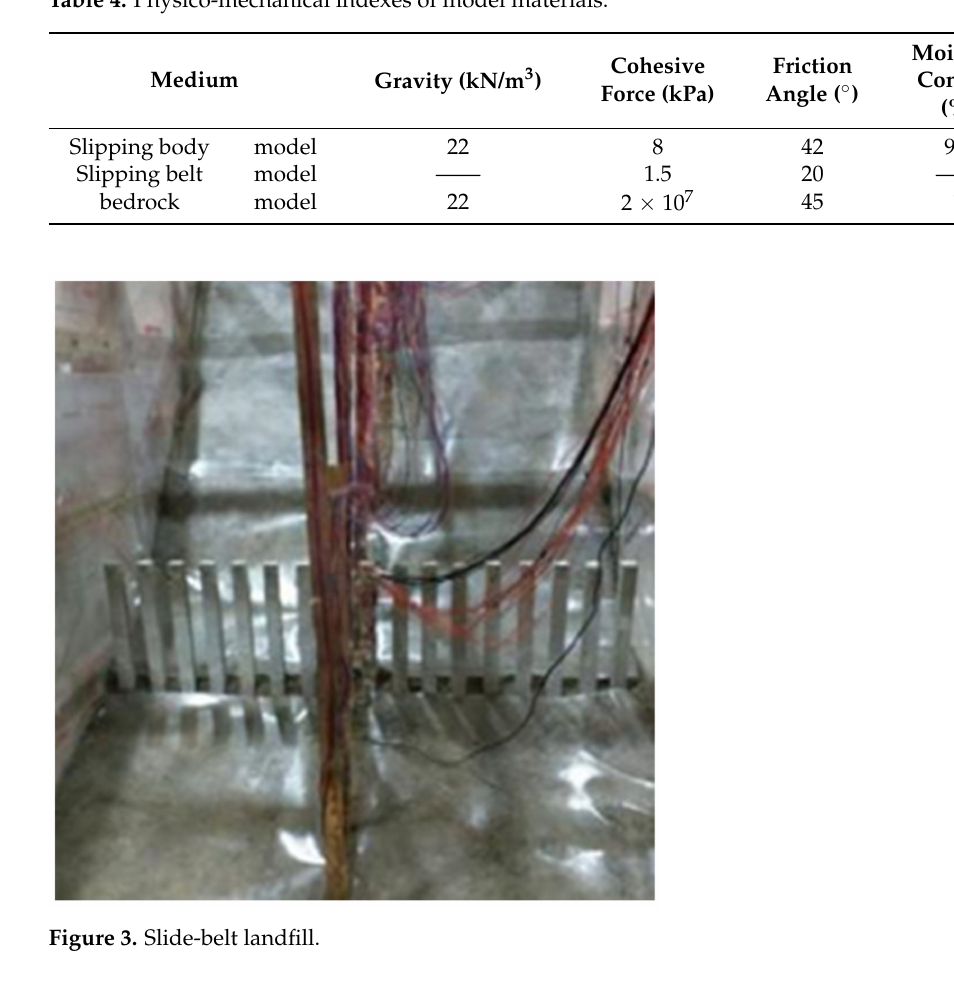
Figure 3. Slide-belt landfill.